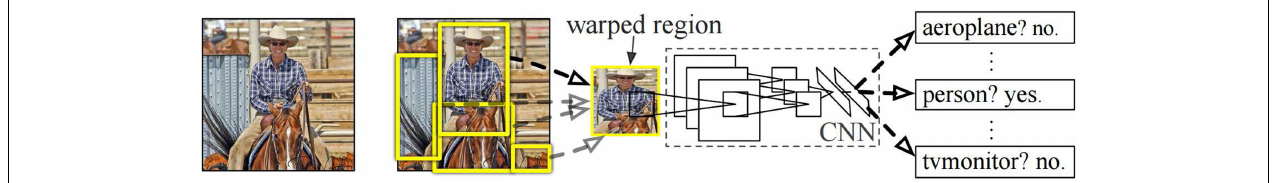
FIGURE 2 | Object detection system of Girshick et al. (2014) using deep features extracted from image regions.